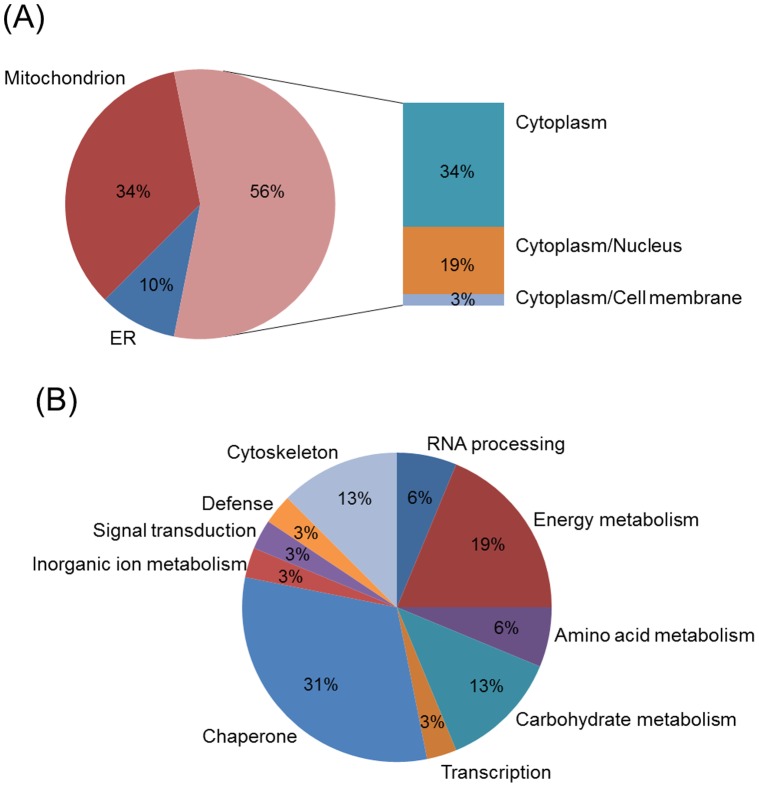
Pie chart distribution of the identified proteins according to cellular location (A) and biological function (B).Proteins were categorized using information from the Swiss-Prot, GO and COG databases. When proteins were associated with more than one function, one category was chosen arbitrarily. ER, endoplasmic reticulum.